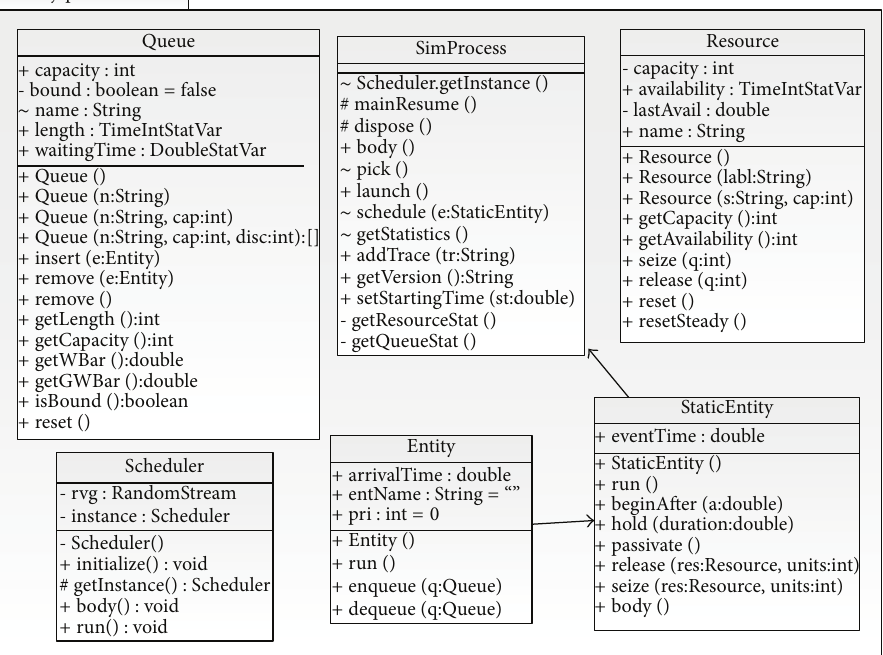
Figure 6: The kernel package.